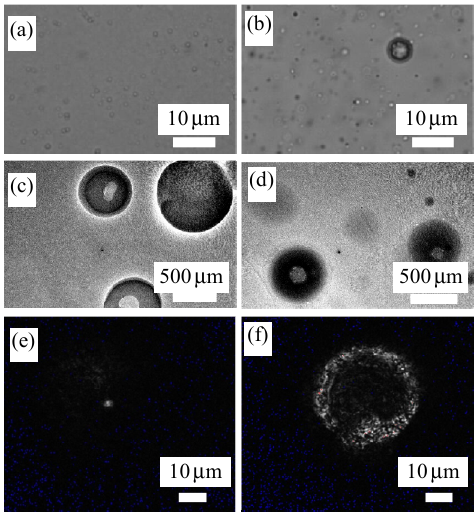
Fig. 3 Vesicles images: microscope image of vesicles (a) with and (b) without the dye dopant, and TEM images of vesicles (c) with and (d) without dye dopant. The CLSM image of the vesicle composed of PNIPAM-b-PAzPy2 with dye from (e) the bottom slice to (f) the middle slice of the